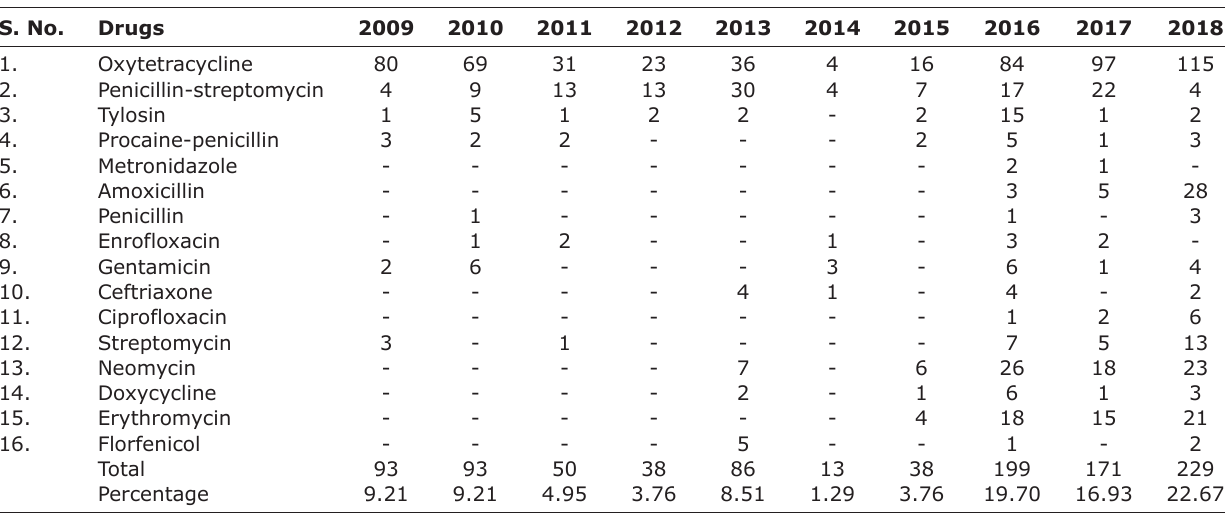
Table-4: Yearly distribution of antibiotics used in the UMVTH. S. No.